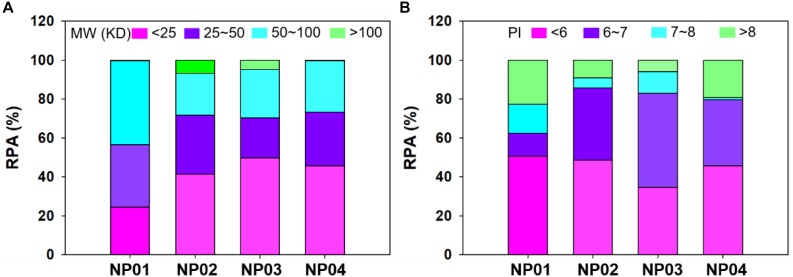
Relative protein abundance of protein corona classified according to their molecular mass (A) and isoelectric point (B).